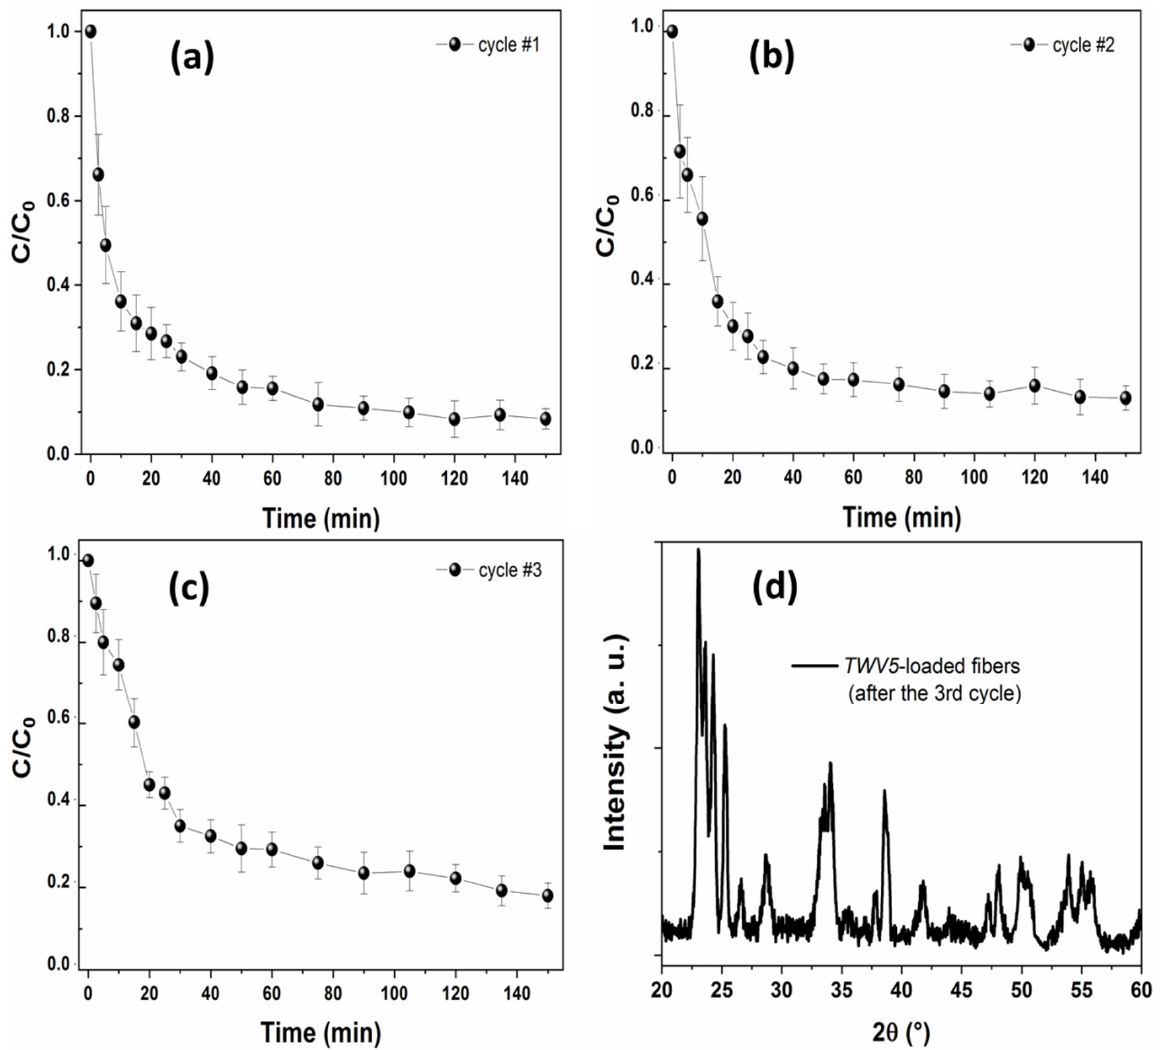
Figure 11. ( a – c ) Dye photodegradation cycles using TWV5 -loaded fibers, under visible light exci- tation; ( d ) XRD spectrum of TWV5 − loaded fibers, after the third cycle of photodegradation. ( d ) XRD spectrum of TWV5-loaded fibers, after the third cycle of